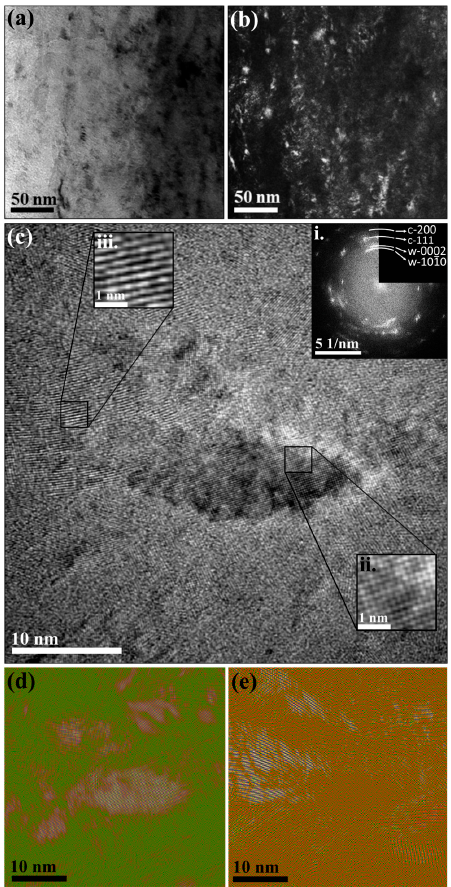
Figure 9. Bright-field ( a ) and dark-field ( b ) transmission electron micrographs of coating A highlighting B4 domains. The high-resolution transmission electron micrograph of coating A is shown in ( c ). The insets depict the fast Fourier transform (FFT) ( ci ) of ( c ), and magnified lattices of the B1 ( cii ) and B4 ( ciii ) phases. The inverse FFT of ( c ) is shown based on the information of the cubic 111 and 200 rings in ( d ), while in ( e ), it is only based on the information of the wurtzite 10 10 and 0002 rings. Coatings 2019 , X , x FOR PEER REVIEW